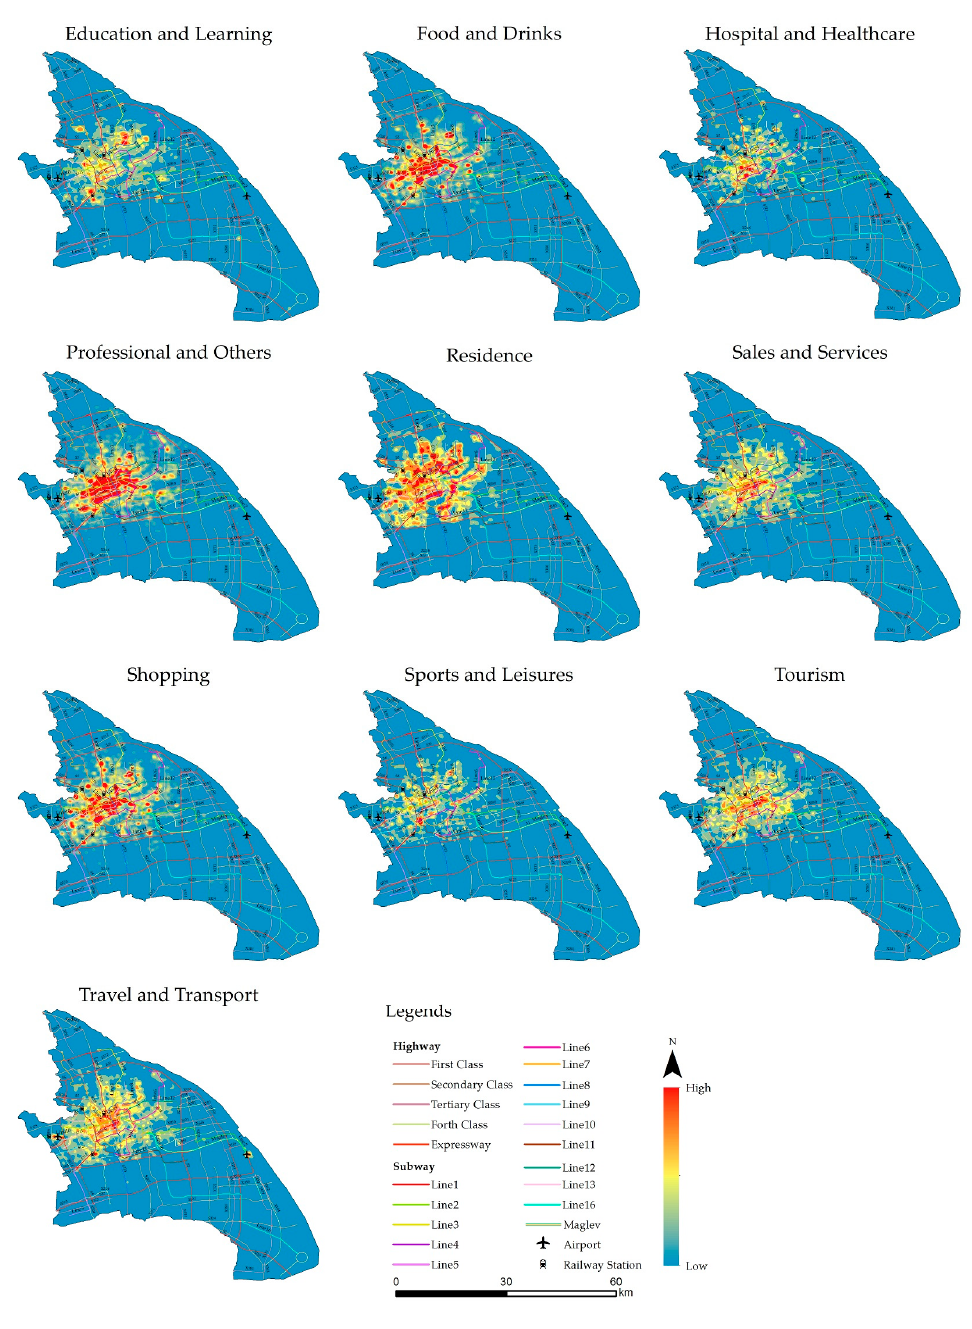
Figure 6. Kernel density of activities in Shanghai.